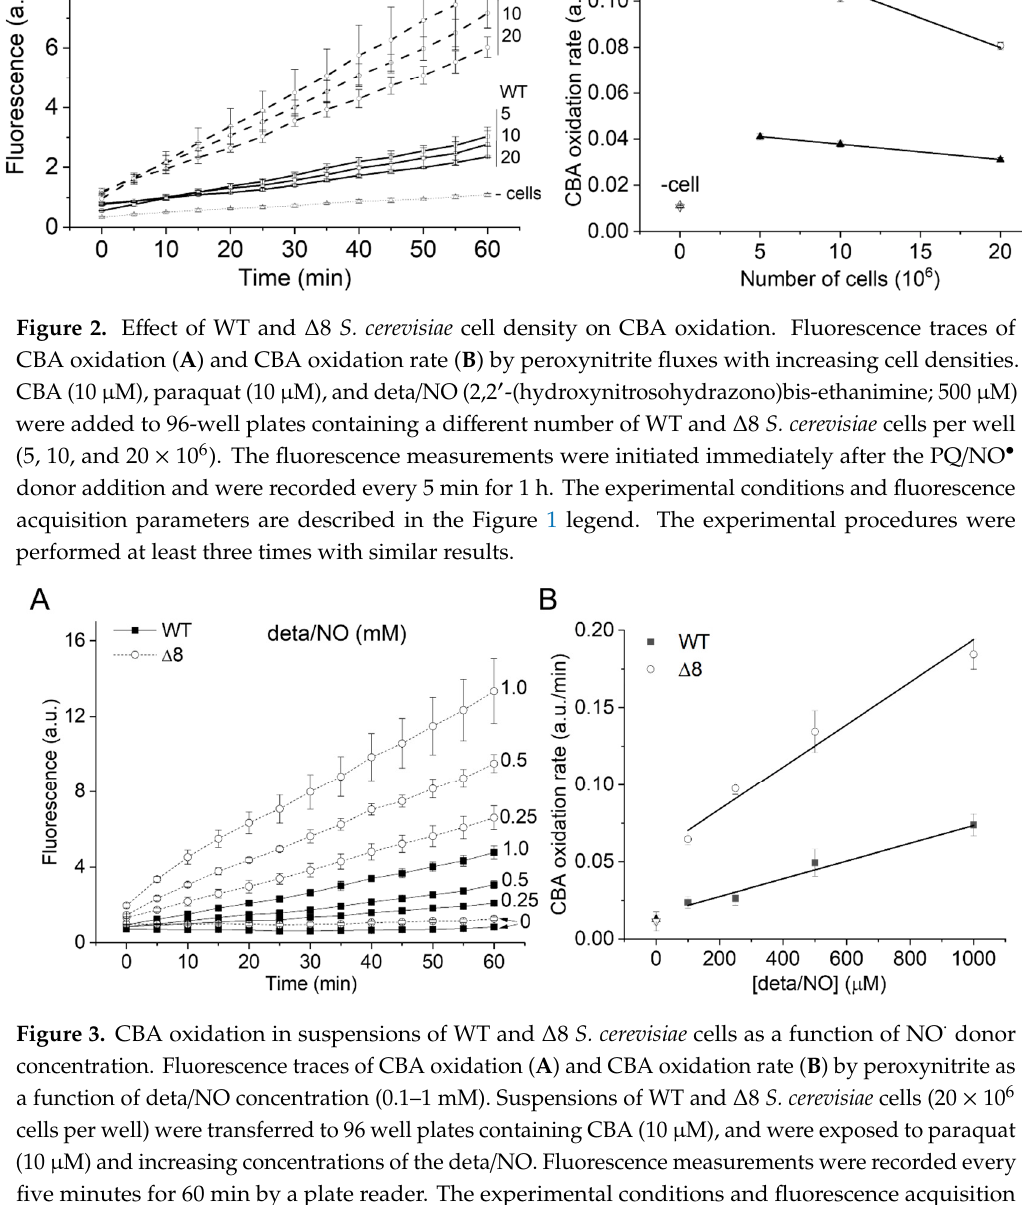
Figure 3. CBA oxidation in suspensions of WT and Δ 8 S. cerevisiae cells as a function of NO • donor concentration. Fluorescence traces of CBA oxidation ( A ) and CBA oxidation rate ( B ) by peroxynitrite as a function of deta/NO concentration (0.1 – 1 mM). Suspensions of WT and Δ 8 S. cerevisiae cells (20 × 10 6 cells per well) were transferred to 96 well plates containing CBA (10 μ M), and were exposed to paraquat (10 μ M) and increasing concentrations of the deta/NO. Fluorescence measurements were recorded every five minutes for 60 min by a plate reader. The experimental conditions and fluorescence acquisition parameters are described in the Figure 1 legend.